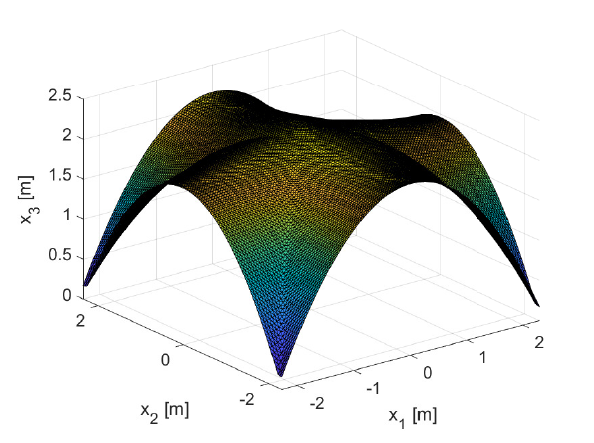
Figure 18. Membrane surface in equilibrium with the stress potential of Figure 17.